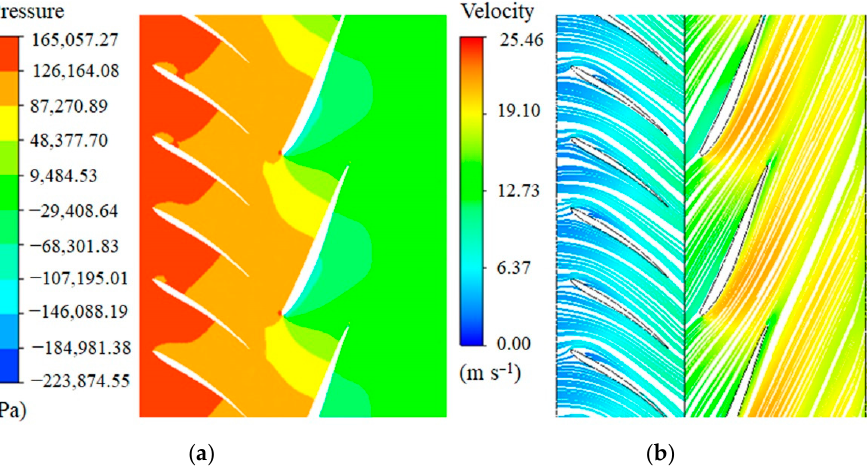
Figure 21. Vane-to-vane pressure and streamline distribution of guide vanes and runner vanes: ( a ) pressure contours; ( b ) streamline contours. Table 7. Performance of guide vane attached to the generator side (short chord, H = 14.84 m).